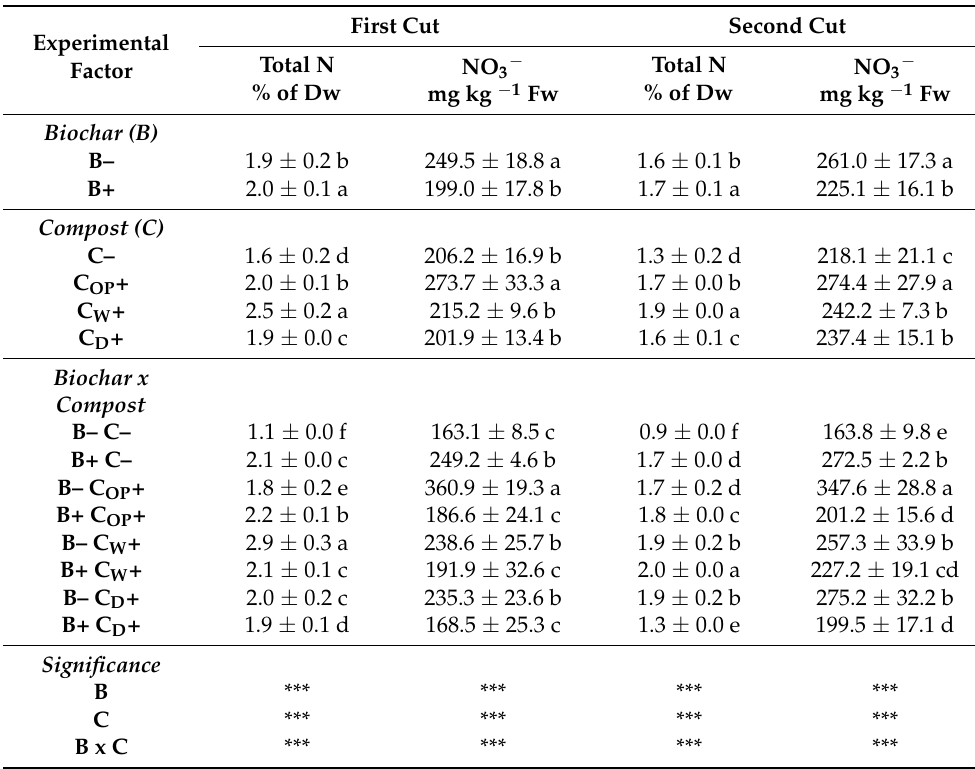
Table 6. Effect of biochar, compost and biochar x compost interaction on total nitrogen (total N) and nitrate (NO 3 − ) leaf content, at the first and second cut of Swiss chard. First Cut Second Cut Experimental Total N NO 3 Factor % of Dw